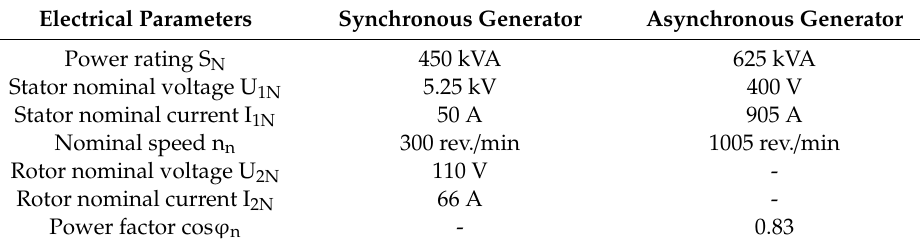
Figure 5. Simplified diagram of the hydroelectric power station. Table 3. Basic parameters of